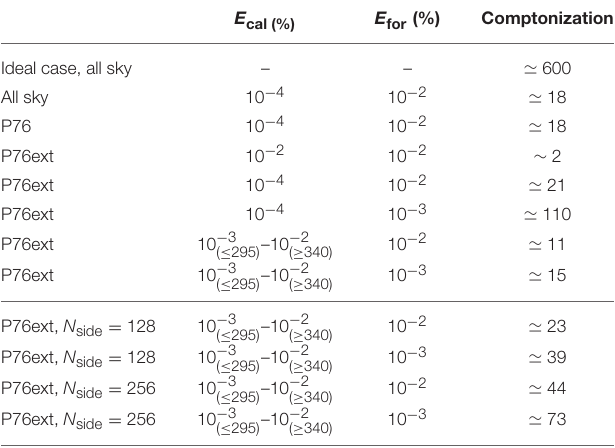
TABLE 4 | Predicted improvement in the recovery of the distortion parameters discussed in the text with respect to FIRAS for different calibration and foreground residual